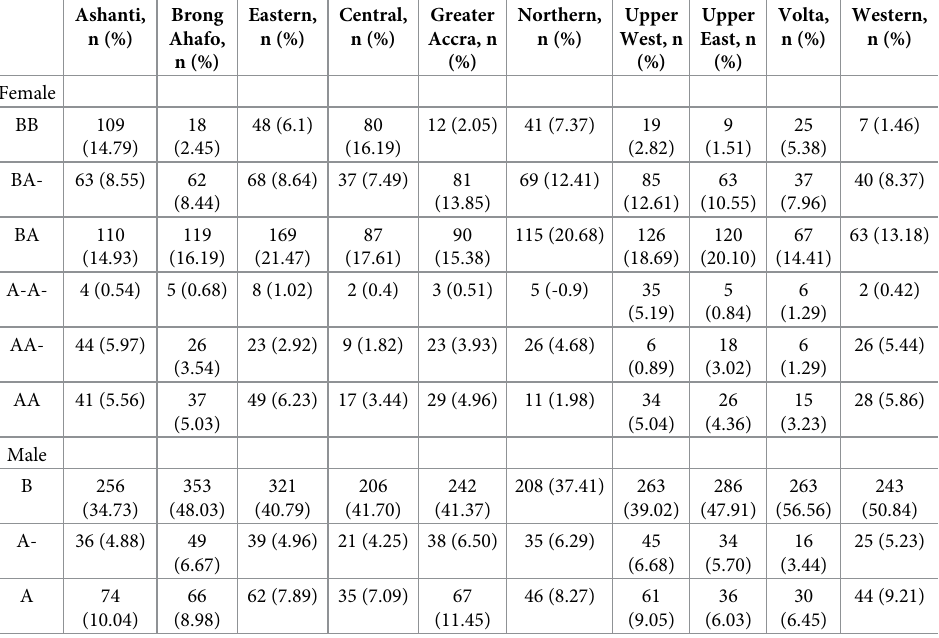
Table 3. The regional distribution of individuals with varying G6PD genotypic variants in Ghana.